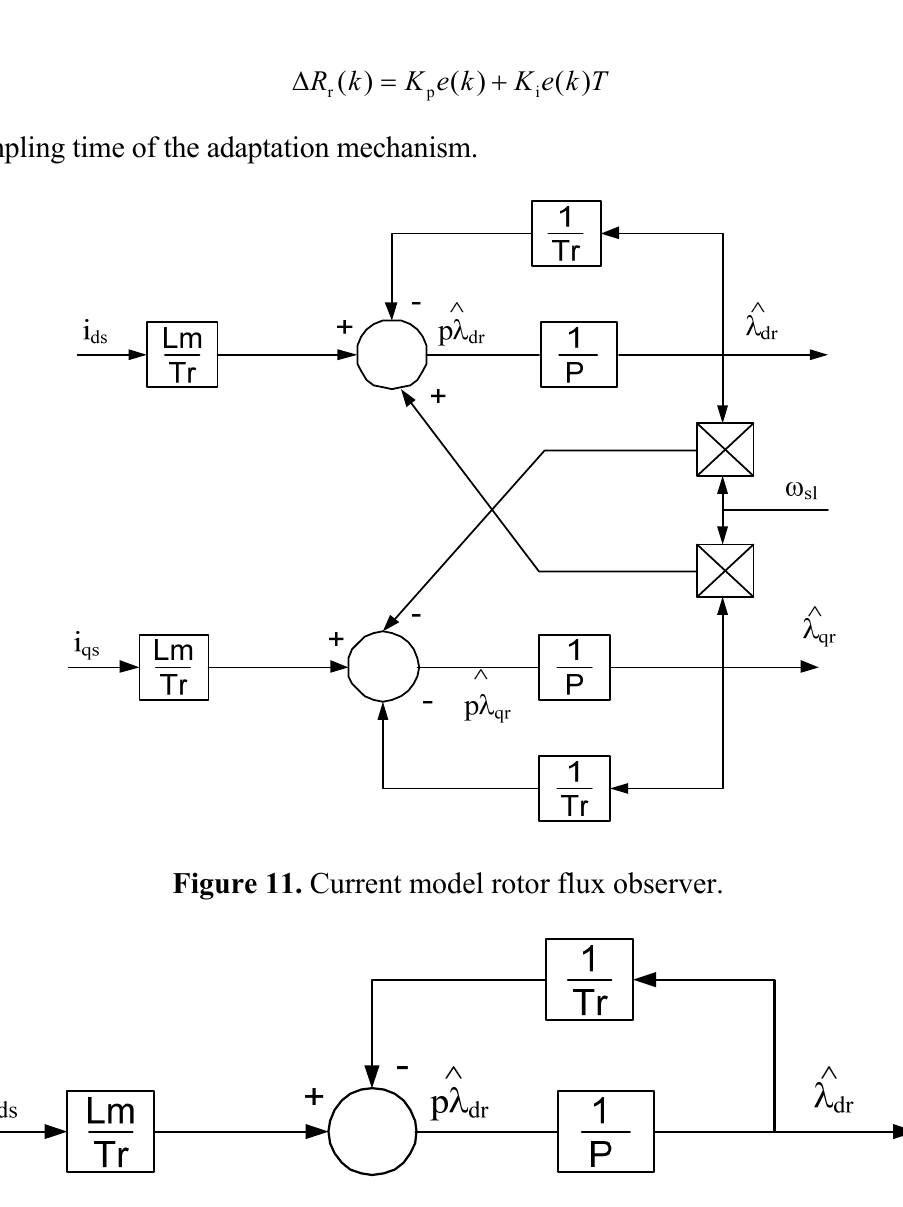
Figure 12. A tuned current model rotor flux